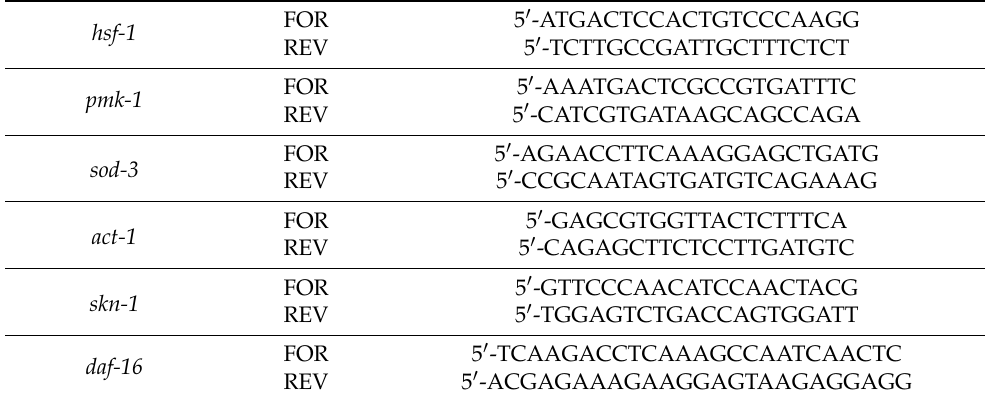
Table 1. Primers for real-time qPCR